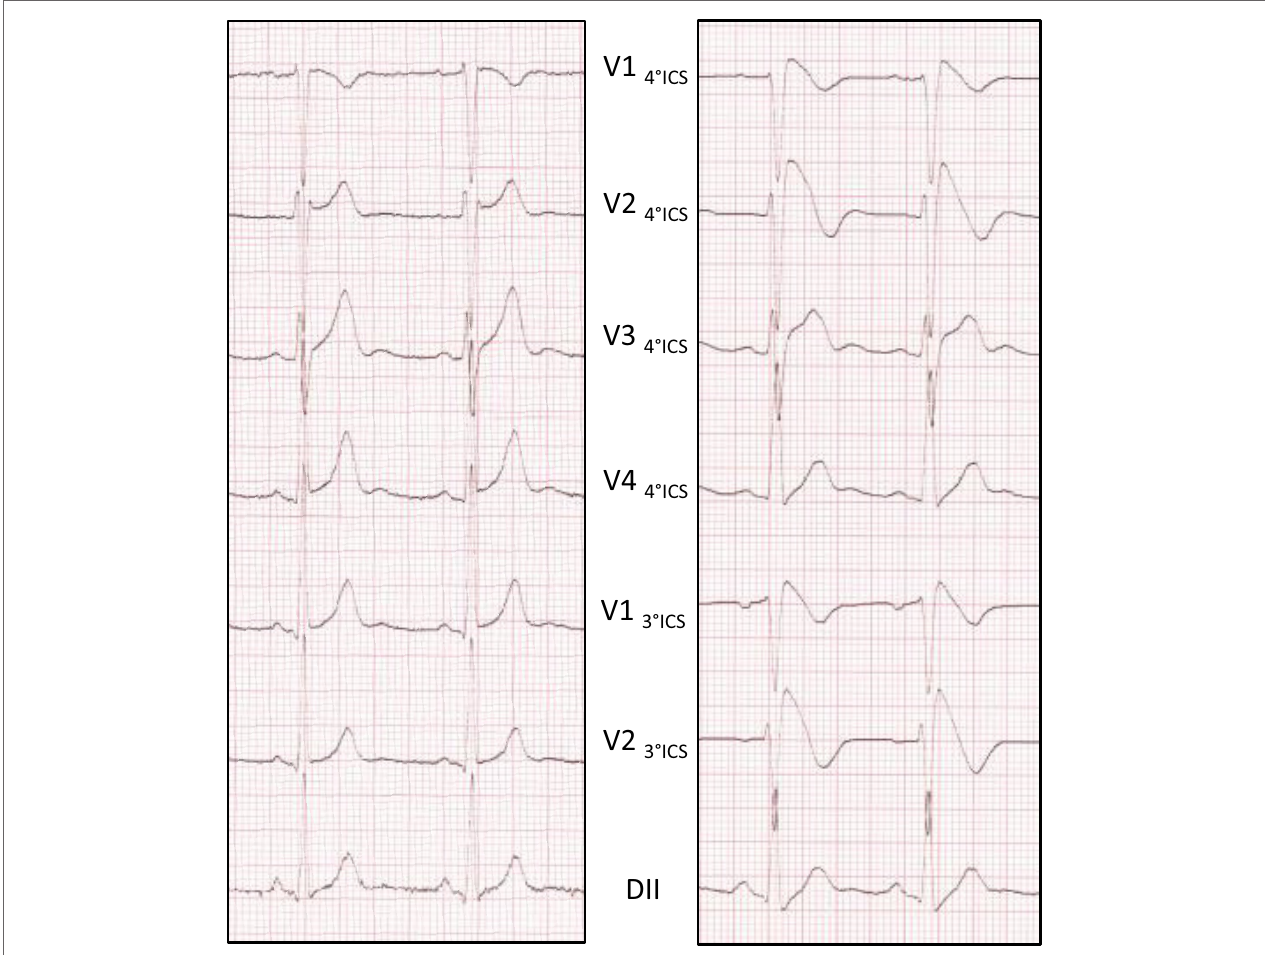
FiGURe 1 | Ajmaline testing reveals the Brugada eCG pattern . ECG pattern is recorded at 1 mm/10 mV and 25 mm/s. Baseline ECG without aspect of BrS (left side). Type 1 Brugada pattern on the right precordial leads at the end of the test (right side).